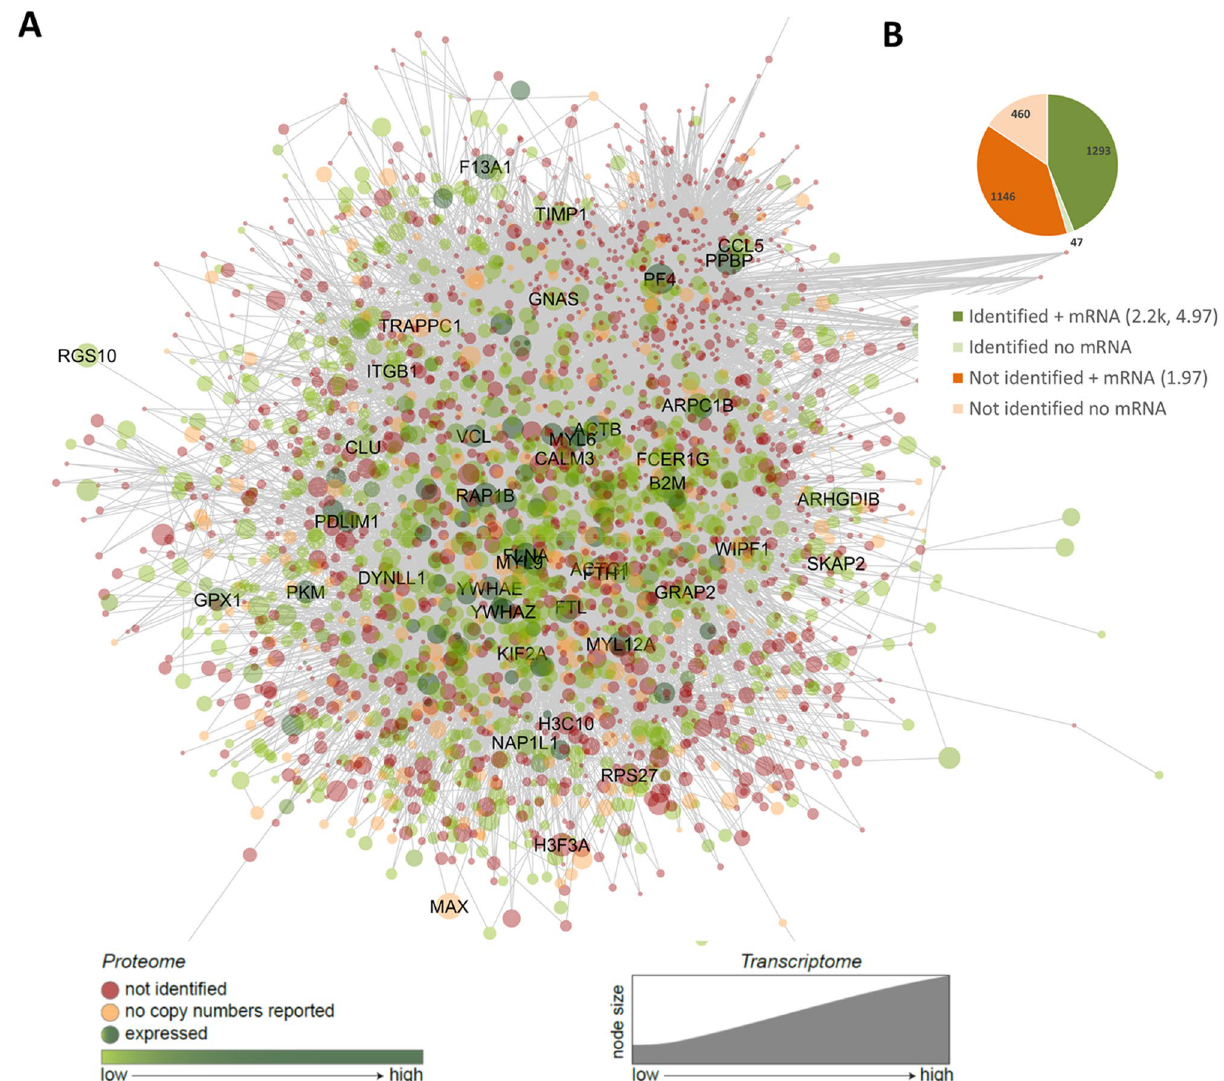
Figure 8. Network-based potential roles of (non)identified proteins in platelet proteome in arterial thrombosis and hemostasis. Using a published meta-analysis of mouse genes in thrombosis and bleeding, the network was built in Cytoscape, containing 267 core genes (bait nodes), 2679 new nodes, connected by 19.7 k interactions 15 . ( A ) Redrawn network visualization with color-coded proteins identified (green) or not identified (red) in the platelet proteome, with relevant transcript levels (node size, log2fpkm). Names are listed of 40 proteins with highest mRNA expression levels. ( B ) Distribution profile of (non)identified proteins with transcript levels (median copy numbers, median log2pkm). No mRNA = below relevant threshold. Attribute lists are given in Suppl. Datafile